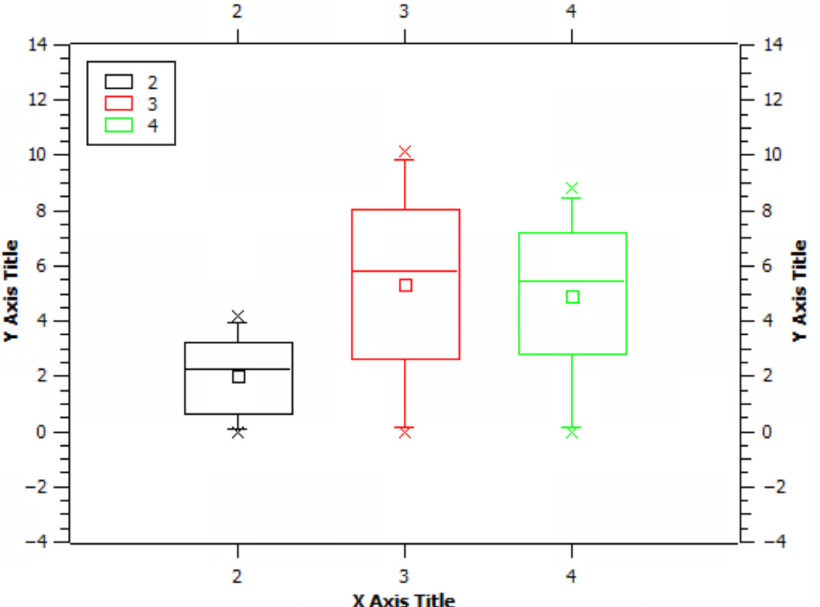
Figure 8. Graphical representation of the statistical evaluation of the influence of the burner’s position on the mass loss of the sample when eco-panels in groups A, B, and C were exposed to the flame. Legend: X Axis Title = Samples. (2-Group A samples; 3-Group B samples; 4-Group C samples.) Y Axis Title = Mass